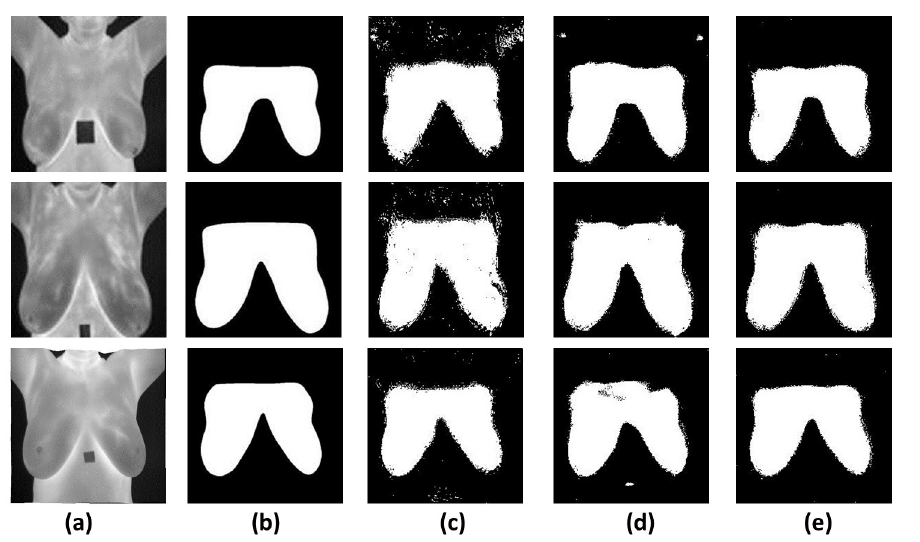
Fig 6. Examples of segmentation process with U-Net before and after using the proposed pooling blocks. (a) original images. (b) labels. (c)segmentation with U-Net. (d)segmentation with U-Net+VPB. (e) segmentation with U-Net+ AVG-MAX VPB.